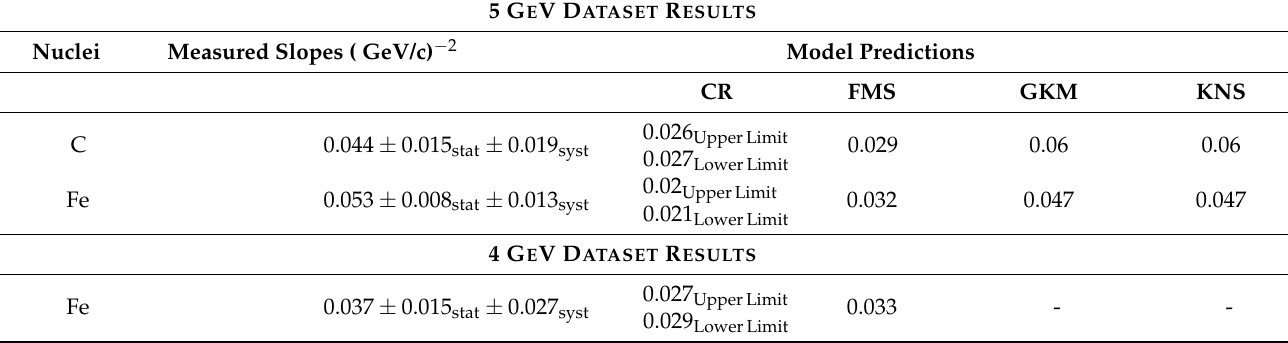
Table 1. Fitted slopes of the Q 2 -dependence of the nuclear transparency for 4 and 5 GeV datasets, as well as nuclei. The results are compared with theoretical predictions of CR [48], FMS [46], GKM [47], and KNS [49]. The two fit values of the CR model are extracted using the upper and lower curves of the hatched bands, shown in Figure